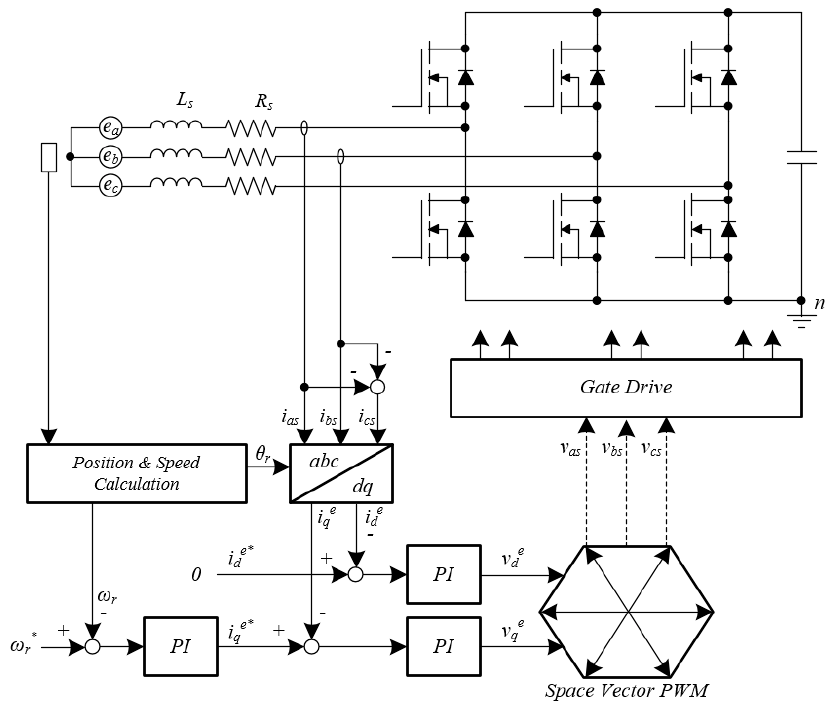
Figure 4. Conventional control configuration for SPMSMs.